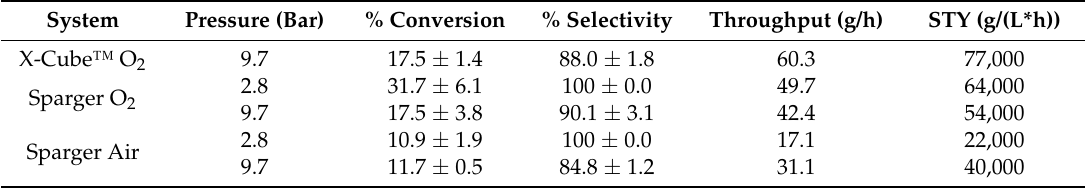
Table 1. Conversion, selectivity, throughput, and space time yield (STY) of the sparged process with air and non-sparged process with pure oxygen.